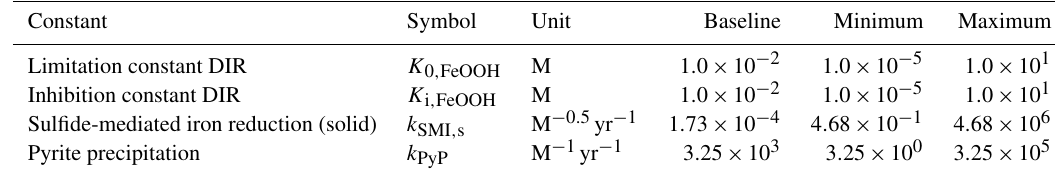
Table A2. Sensitivity range and baseline values of each parameter tested – converted to cGEnIE units. Constant Symbol Unit Baseline Minimum Maximum Limitation constant DIR K 0 ,